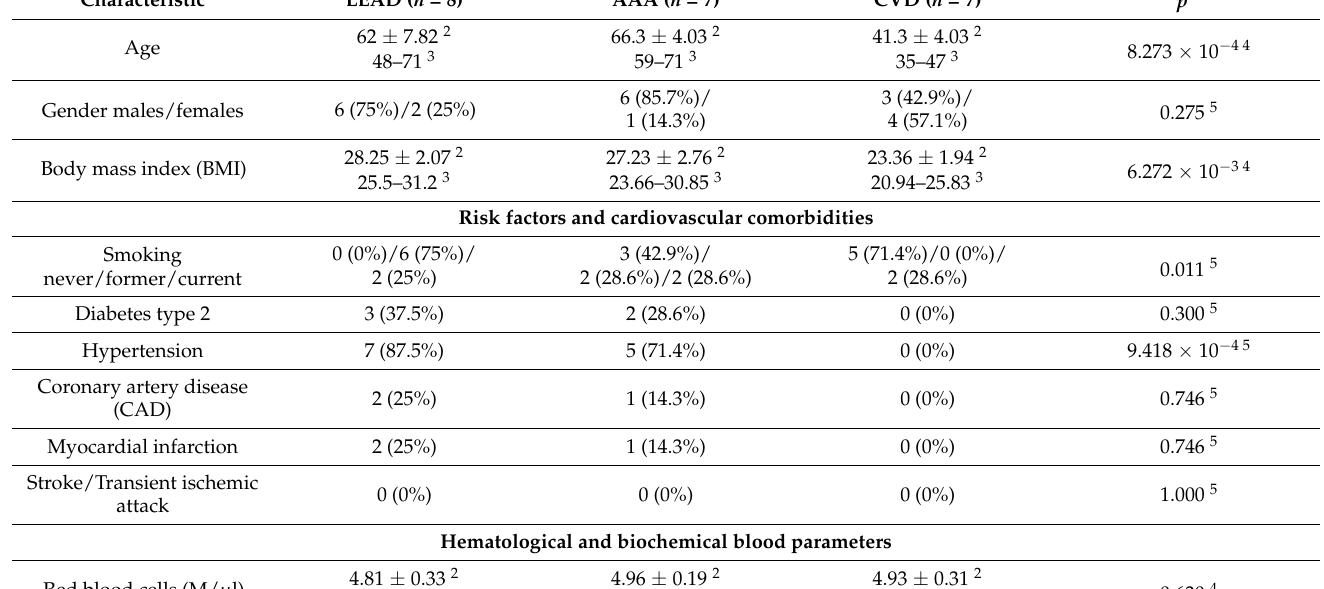
Table 1. Clinical characteristics of the study